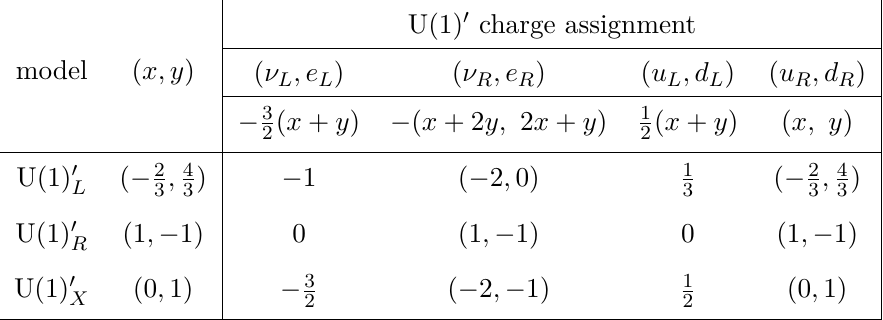
Table 2 . Quantum numbers of fermions in the three chiral U(1) 0 examples considered